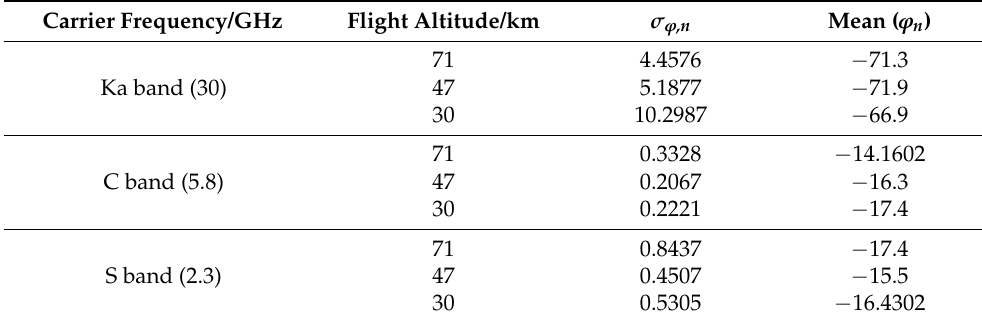
Table 2. Mean value and variance of the phase fluctuation. Carrier